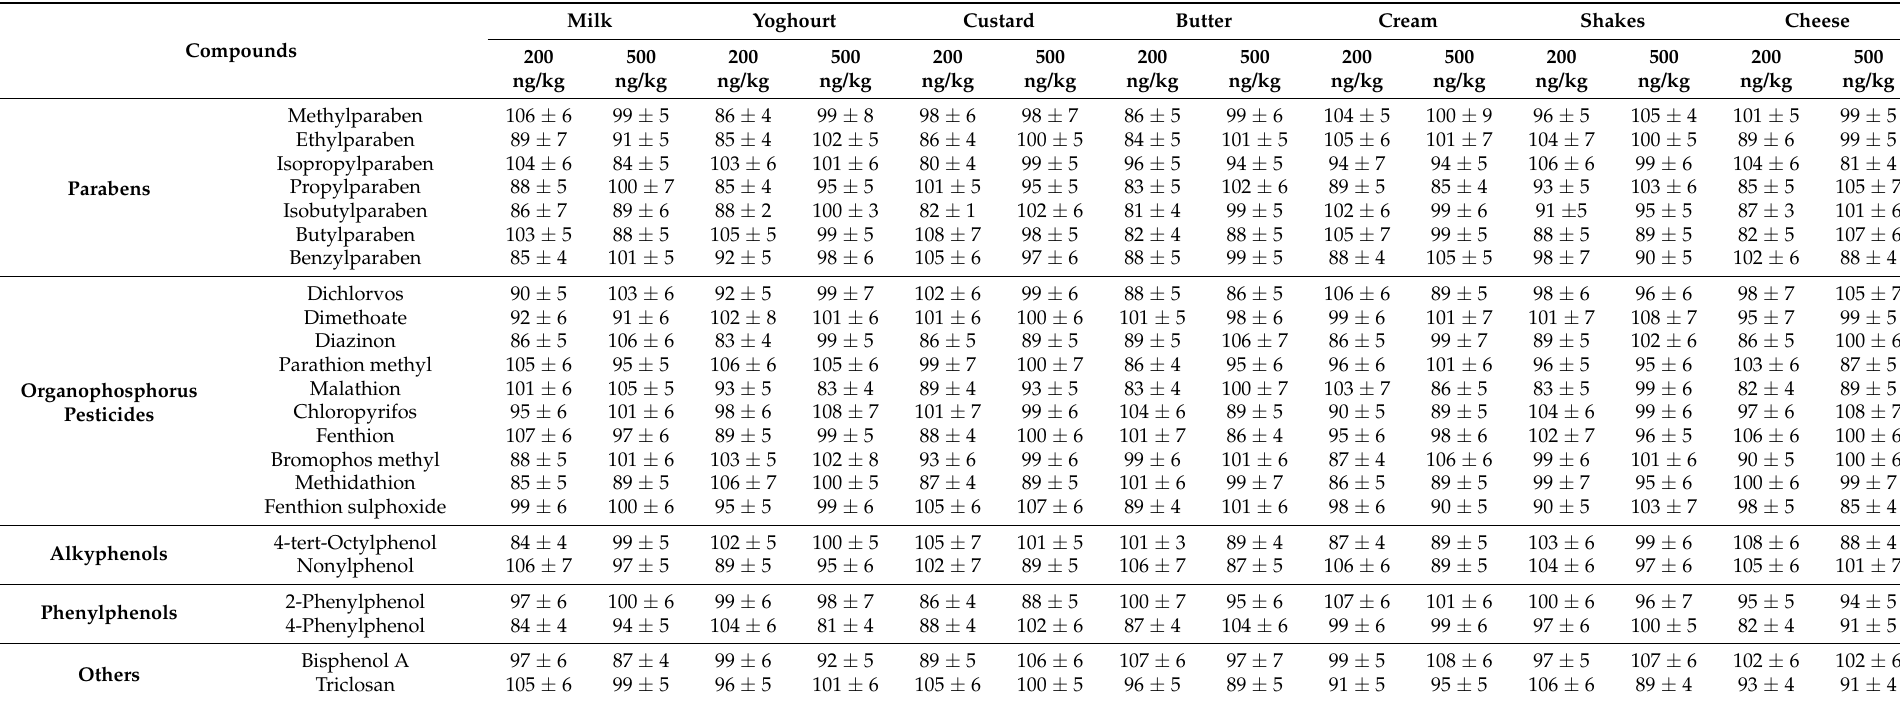
Table 3. Average recoveries (% ± SD, n = 3) of endocrine disrupting chemicals spiked to milk and dairy